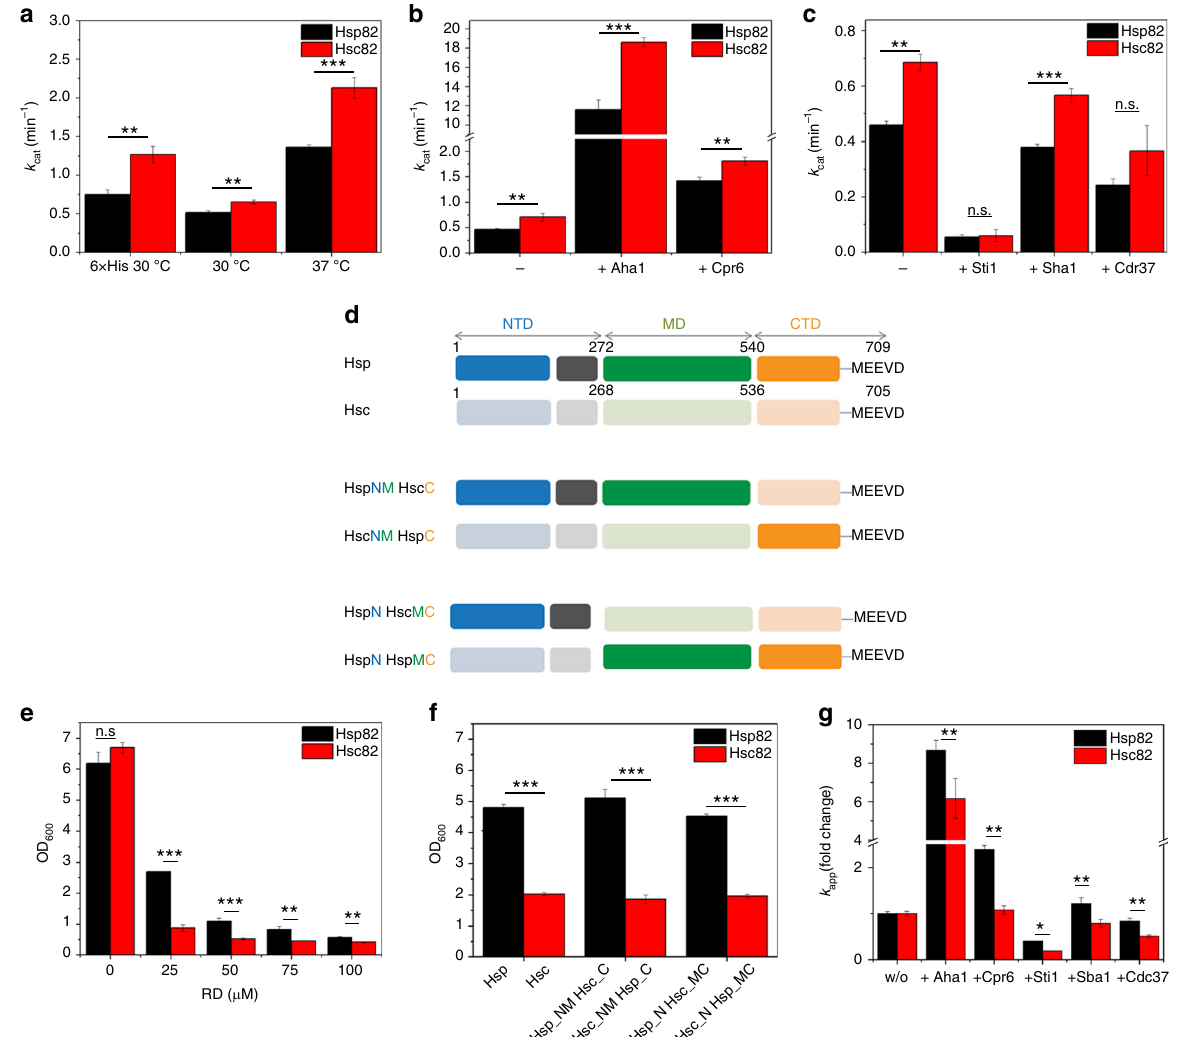
Fig. 3 ATPases, RD sensitivity, and closing kinetics of yeast Hsp90 isoforms. For all measurements three technical replicates were used to determine standard deviations. Statistical signi fi cance was assessed using a two-sample t -test. The level of signi fi cance is indicated (ns: p > 0.05, * p < 0.05, ** p < 0.01, *** p < 0.001. a Comparison of the ATPase activity of tagged (6×His) and untagged Hsp82 and Hsc82 at indicated temperatures. ATPase assays were performed in a standard buffer containing 2 mM ATP and a fi nal concentration of 3 µ M Hsp90. b The isoforms ’ ATPase stimulation by Aha1 or Cpr6 was measured in a low salt buffer containing 40 mM HEPES, pH 7.5, 50 mM KCl, 5 mM MgCl 2 , 2 mM ATP and a fi nal concentration of 1 µ M Hsp82/Hsc82 or 3 µ M Hsp82/Hsc82 in the presence of 30 µ M Aha1 or 15 µ M Cpr6, respectively. c The isoforms ’ ATPase inhibition by Sti1, Sba1, and Cdc37 was measured in the low salt buffer containing a fi nal concentration of 3 µ M Hsc82/Hsp82 in absence of co-chaperone and in presence of 7.5 µ M Sti1, 10 µ M Sba1, and 20 µ M Cdc37. d Scheme depicting Hsp90 chimeras used for RD assay shown in e . e Yeast expressing either Hsc82 or Hsp82 as the sole Hsp90 source was grown in the absence or presence of indicated concentration of the Hsp90 inhibitor RD. Yeast cell growth was measured after 20 h at OD 600 . f RD sensitivity of chimera of Hsp82 and Hsc82. The assay was performed as described in e . g Nucleotide-induced closing kinetics of Hsp82 and Hsc82 were recorded by FRET in the presence 2 mM ATP γ S, in the absence of co-chaperone, or in the presence of the co-chaperone Aha1, Cpr6, Sti1, Sba1, Cdc37. The fold change (fc) in the closing kinetics constant ( k app ) in the presence of co-chaperones compared k app in the absence of co-chaperones is shown for both shift differences of the backbone amide NMR signals of the two isoforms. Interestingly, apart from positions adjacent to residues that are different in the two isoforms, signi fi cant CSPs appear in additional allosteric regions (Fig. 5b, top). When plotted on the structure, most of these regions cluster at the C-terminal end of helix α 2 and loop 139 – 145, extending to the neighboring 81 – 85 loop and helix α 3 near the binding pocket (Fig. 5b, bottom). four of the amino acid changes. One of them leads to a disruption of the salt bridge between Lys48 and Asp142 that is seen in the crystal structure of the Hsp82 NTD 27 .